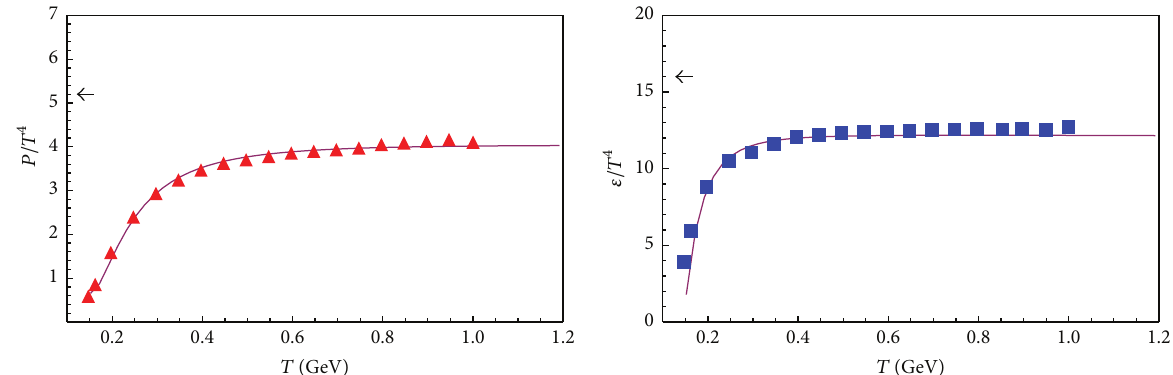
Figure 3: The symbols show the MC LR for the pressure and the energy density in case of 𝑛 𝑓 = 2 + 1 QCD equation of state [37, 38]; the line corresponds to the equation of state (35) for the pressure in the left panel and (36) for the energy density in the right panel with 𝜎 = 12.22017 , 𝐵 = −10.4353𝑇 4 𝑃/𝜀 = 1/3 (i.e., the SB limit). 𝐴 = −13.8577𝑇 3 𝑐 , and 𝑐 . The arrows in the above figures correspond to